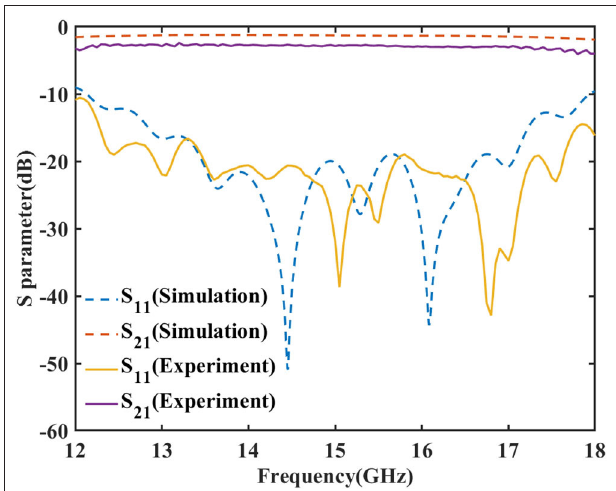
FIGURE 8 | Simulated and measured S